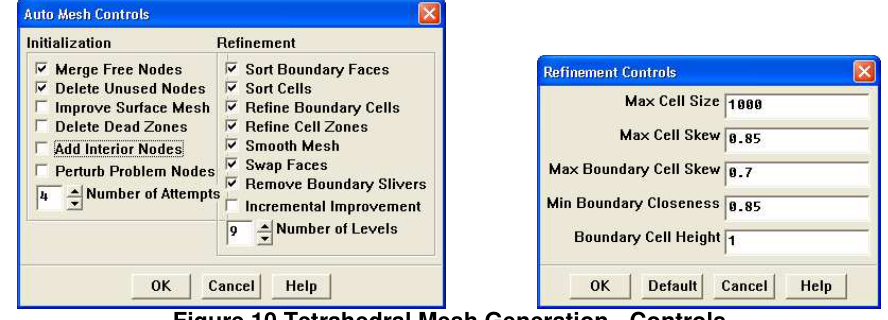
Figure 10 Tetrahedral Mesh Generation -